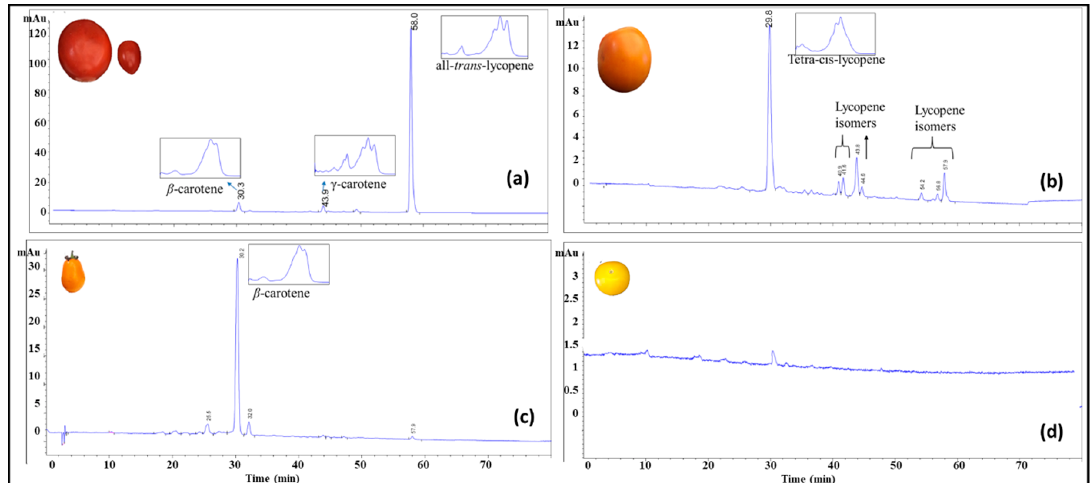
Figure 3. High-performance liquid chromatography (HPLC) chromatogram monitored at 450 nm and their corresponding absorption spectrum collected by the photodiode array detector for carotenoids in selected tomato breeding material. ( a ) Red tomatoes; ( b ) tangerine tomatoes high in tetra-cis-lycopene; ( c ) tangerine tomatoes high in β -carotene; ( d ) yellow tomatoes low in all carotenoid.